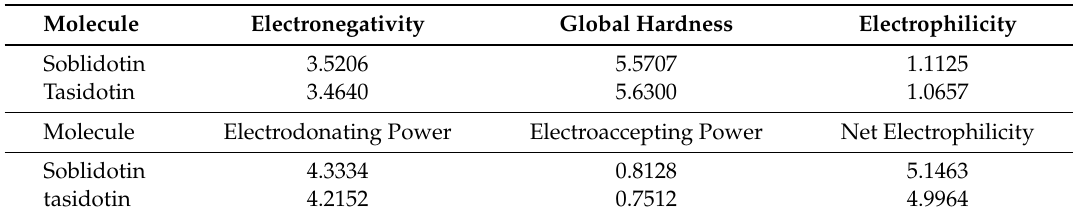
Table 2. Global reactivity descriptors of the anticancer marine peptides Soblidotin and Tasidotin.